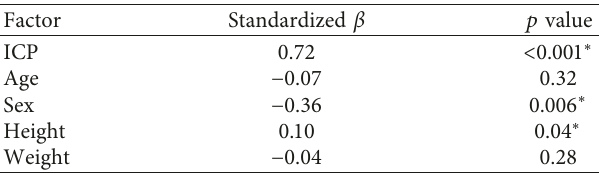
Table 3: Multiple linear regression nested model for ONSD predictors.